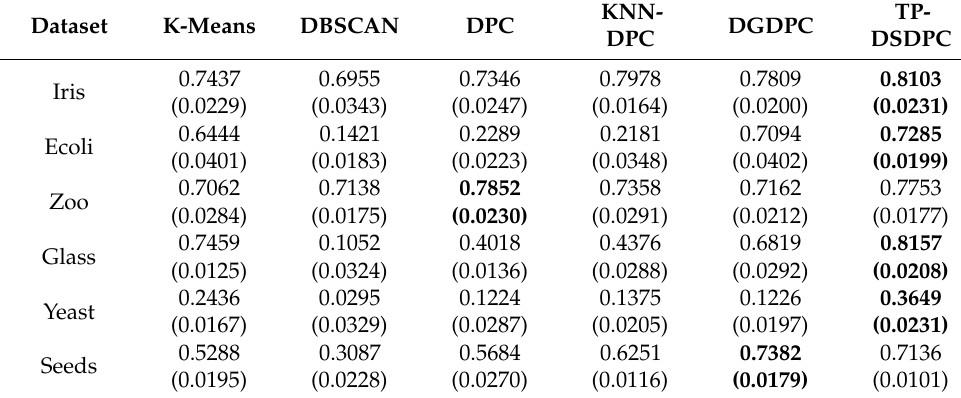
Table 9. Results of NMI on UCI datasets.